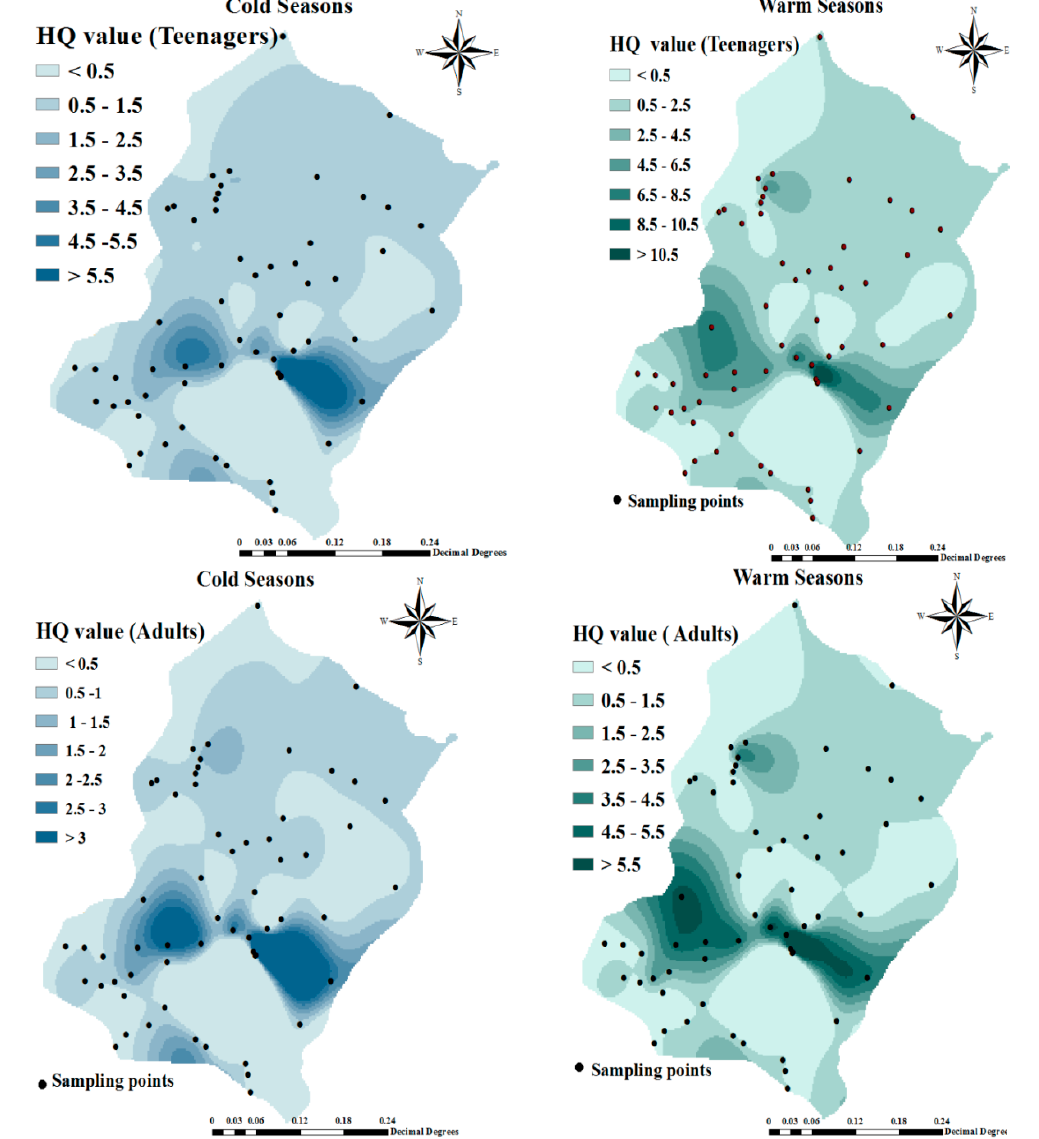
Figure 4. Spatial distribution of HQ in cold and warm seasons for teenagers and adult groups.